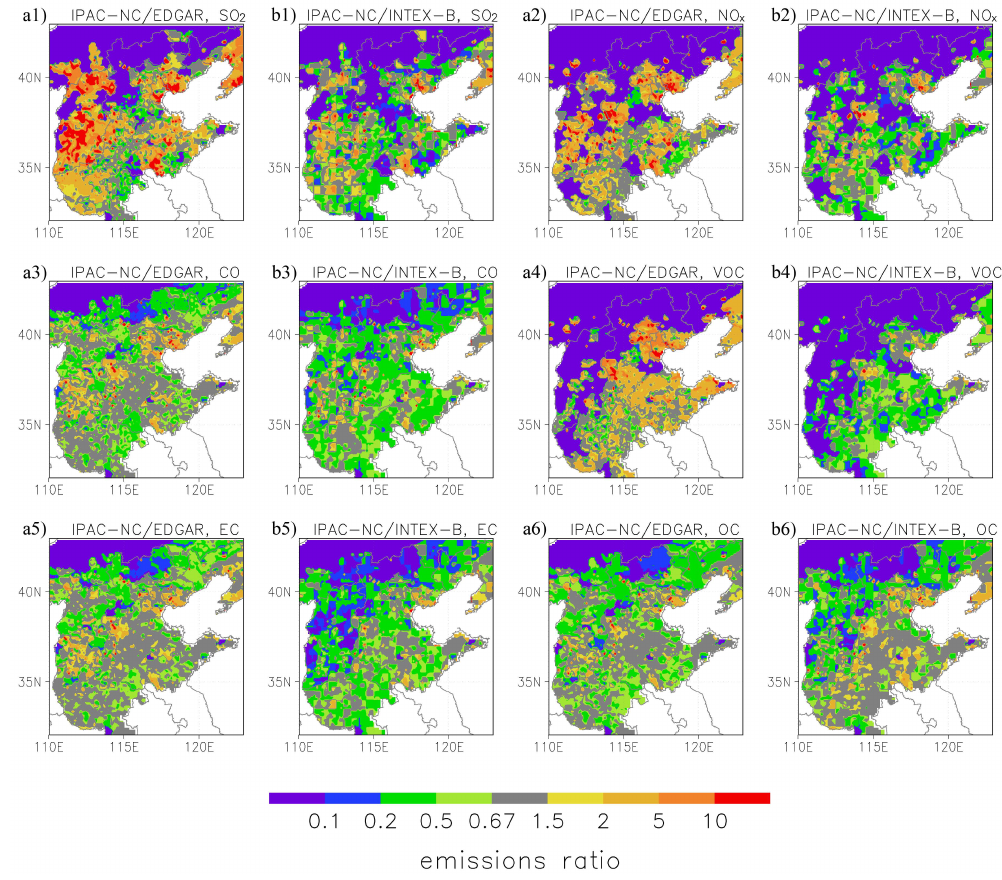
Fig. 8. Spatial distributions of pollutant emission ratios of IPAC-NC to EDGAR (a) and IPAC-NC to INTEX-B (b) based on 0.1 ◦ latitude × 0.1 ◦ longitude grid